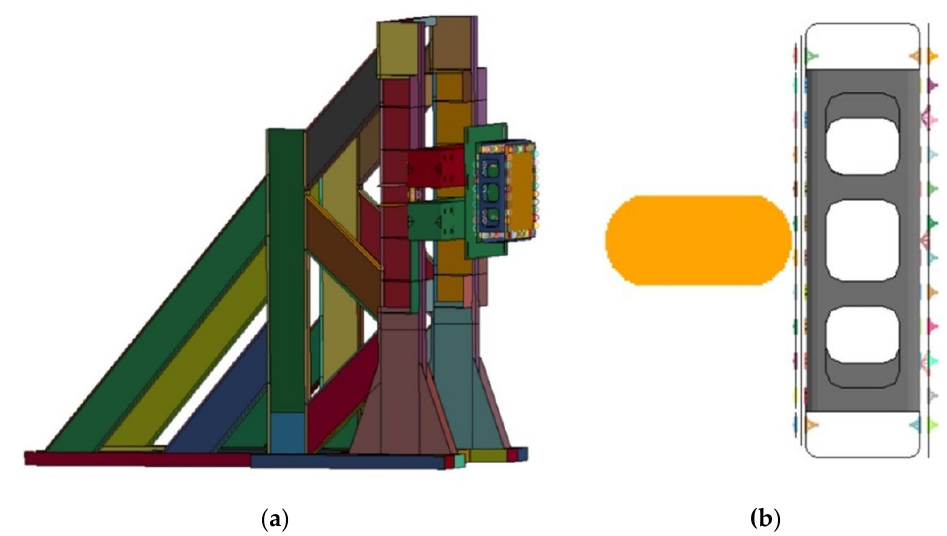
Figure 14. FE model of the stand test ( a ) and the position of the bird model in the initial moment of analysis ( b ).